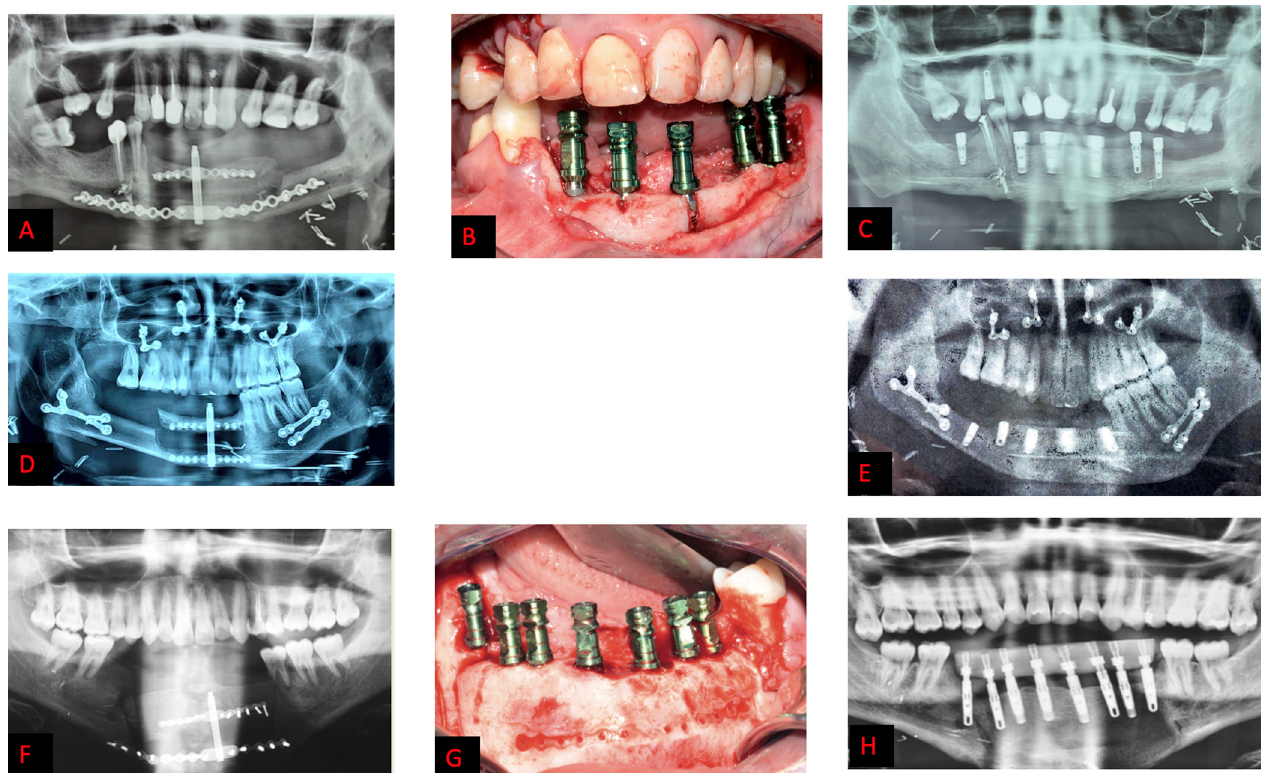
Fig. 5. Signi fi cant vertical ridge augmentation allowing implant placement after distractor removal for patient n ° 1 (Figs 5A, 5B, 5C), for patient n ° 2 (Figs 5D, 5E) and for patient n ° 3 (Figs 5F, 5G,